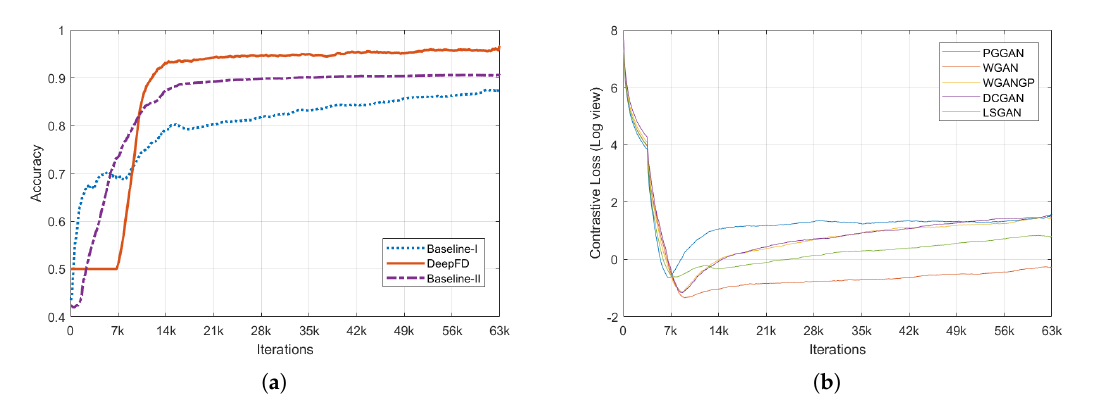
Figure 6. ( a ) The curves of the validation accuracy evaluated on the fake face images generated by PGGAN during the training phase for the proposed DeepFD, Baseline-I, and Baseline-II. ( b ) The curves of the contrastive loss values of the proposed DeepFD (in